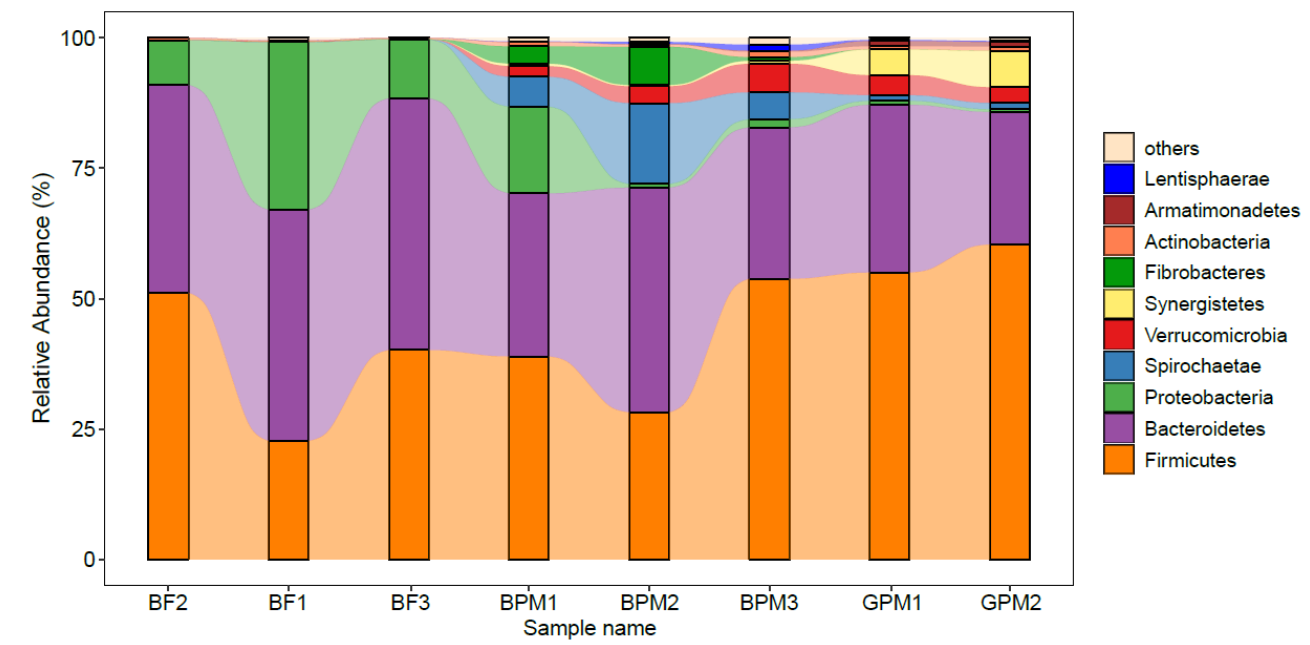
Figure 3. Gut microbial community composition of young elephants at the phylum level.